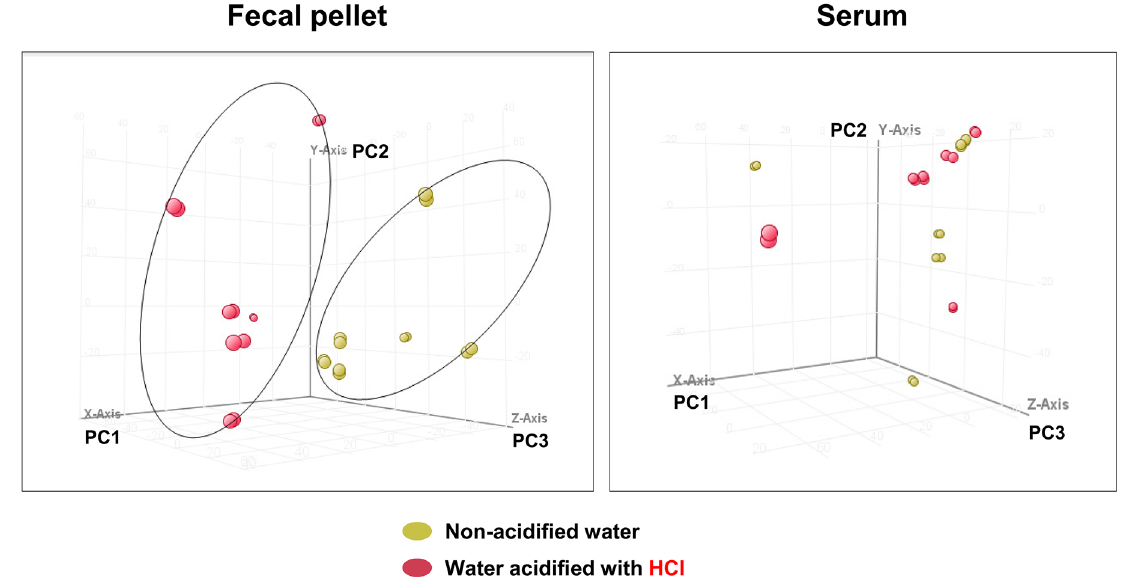
Figure 6. Comparative analysis of the fecal and serum metabolomes of mice kept on non-acidified water and mice that received HCl-acidified water from weaning (postnatal day 21). Fecal and serum samples were compared at 6 months of age using untargeted/global metabolomic analysis. HCl-acidified drinking water markedly changed the global fecal metabolome as shown by clear group separation using principal component analysis. HCl-acidified water had no significant effect on the global serum metabolome: principal component analysis did not show group separation. The double symbols represent two separate sample analyses from an individual mouse (n = 6 mice).